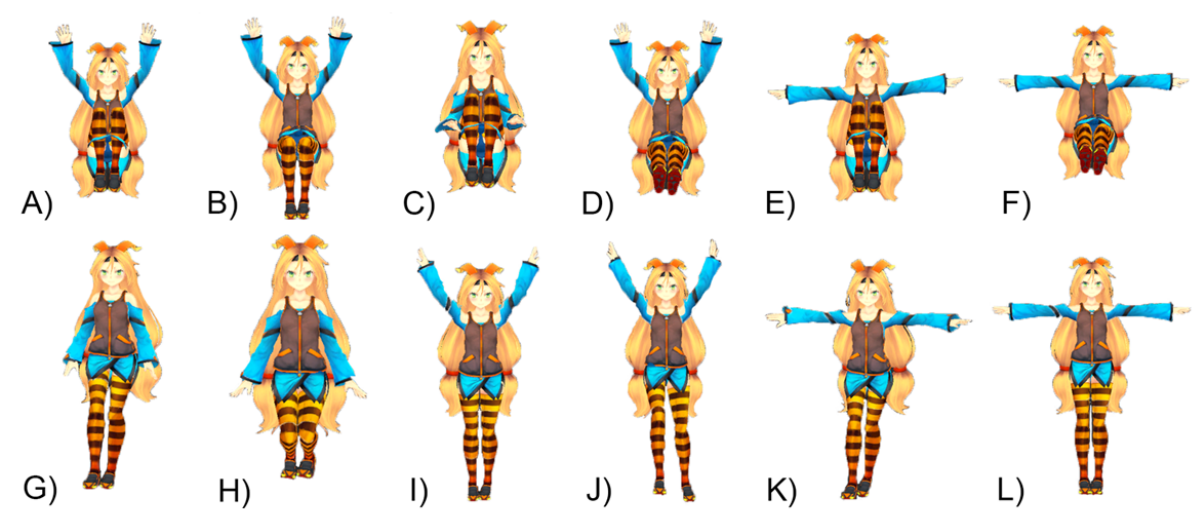
Figure 2. Seated gestures: (A) Hands up + knees up; (B) Hands up; (C) Knees up; (D) Feet up + hands up; (E) Hands stretched + knees up; (F) Hands stretched + feet up. Standing gestures: (G) Left/right kick; (H) Squat; (I) Hands up; (J) Left/right kick + hands up; (K) Left/right kick + hands stretched; (L) Hands